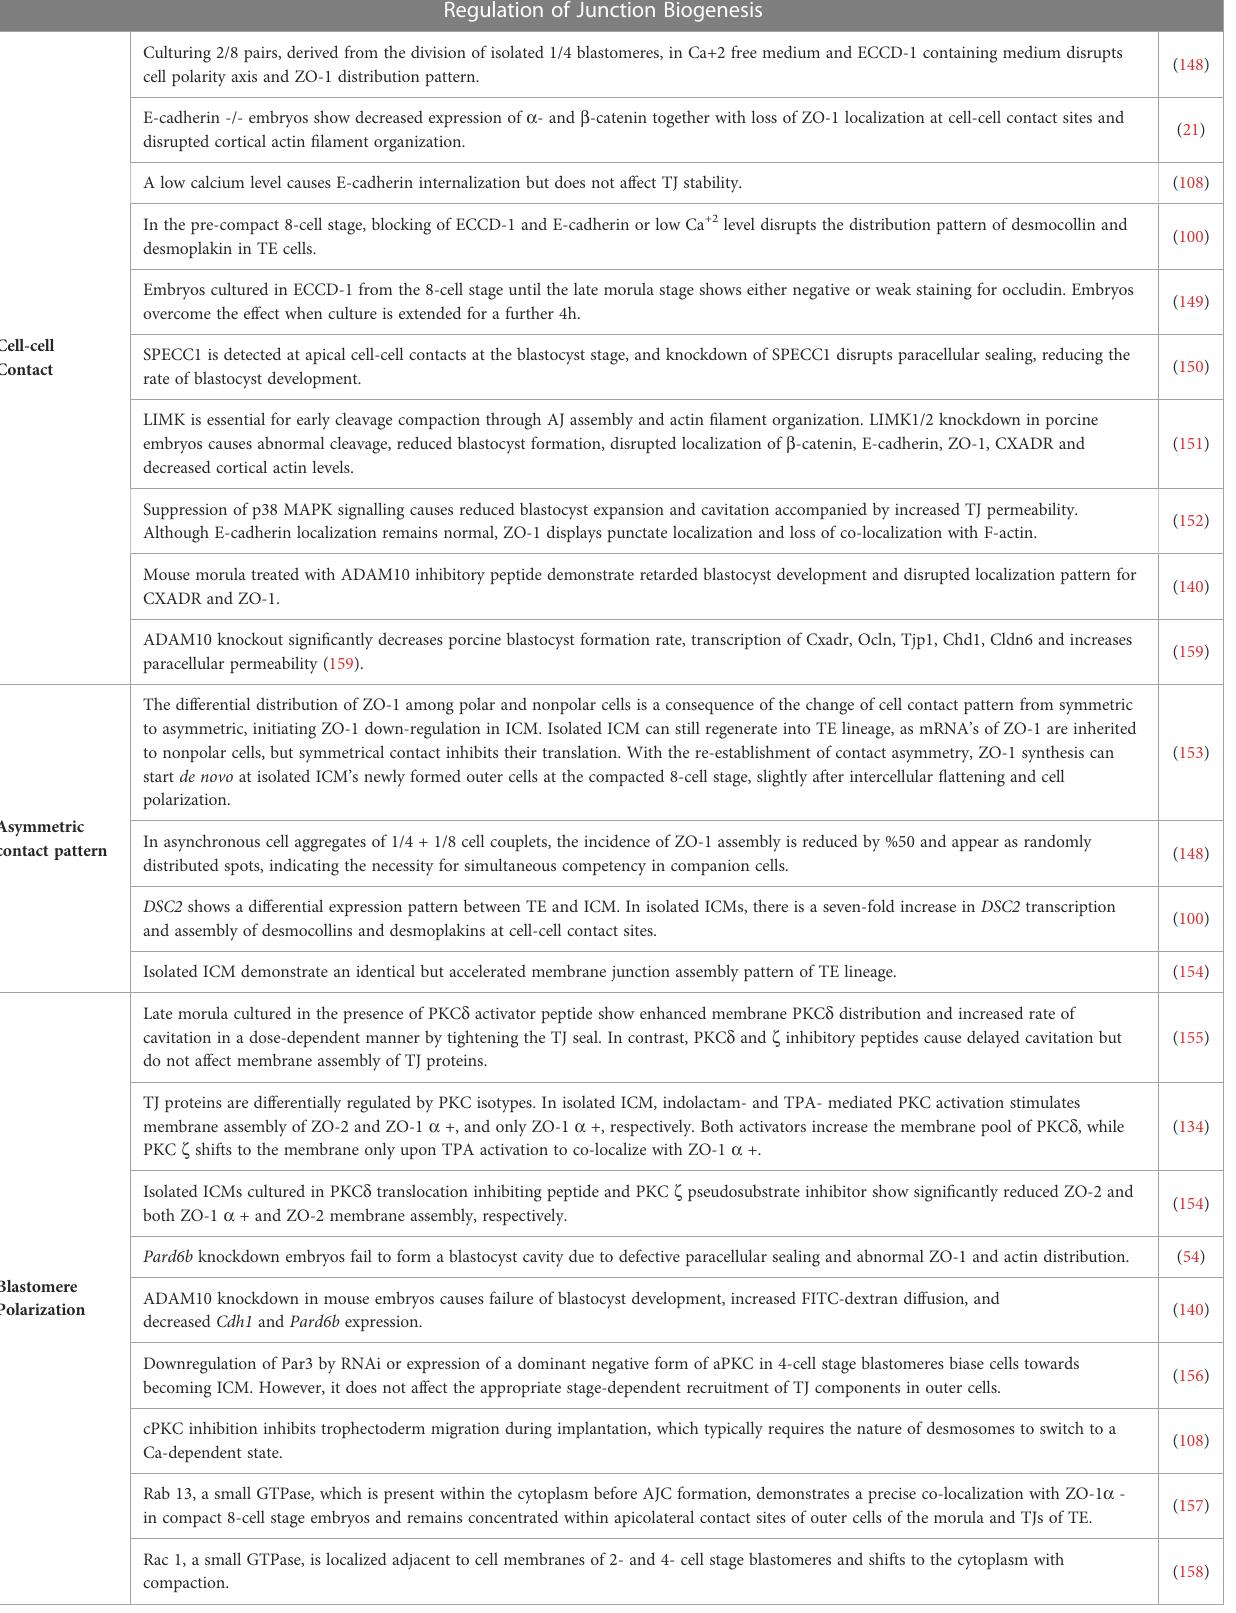
TABLE 1 Determinants of junction biogenesis during preimplantation embryo